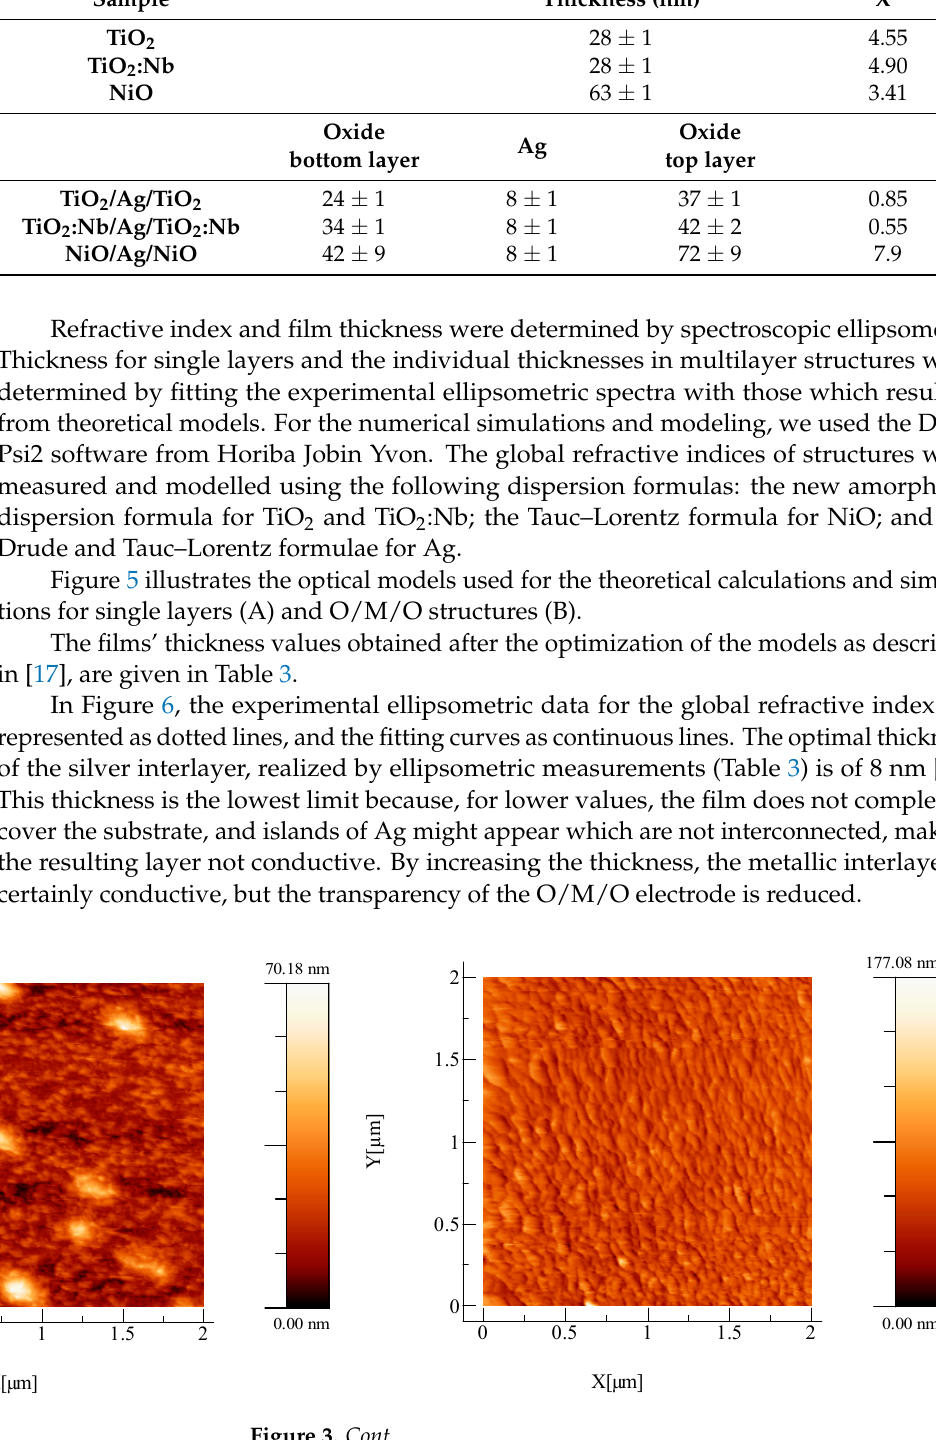
Table 3. Thicknesses obtained from ellipsometry simulations.